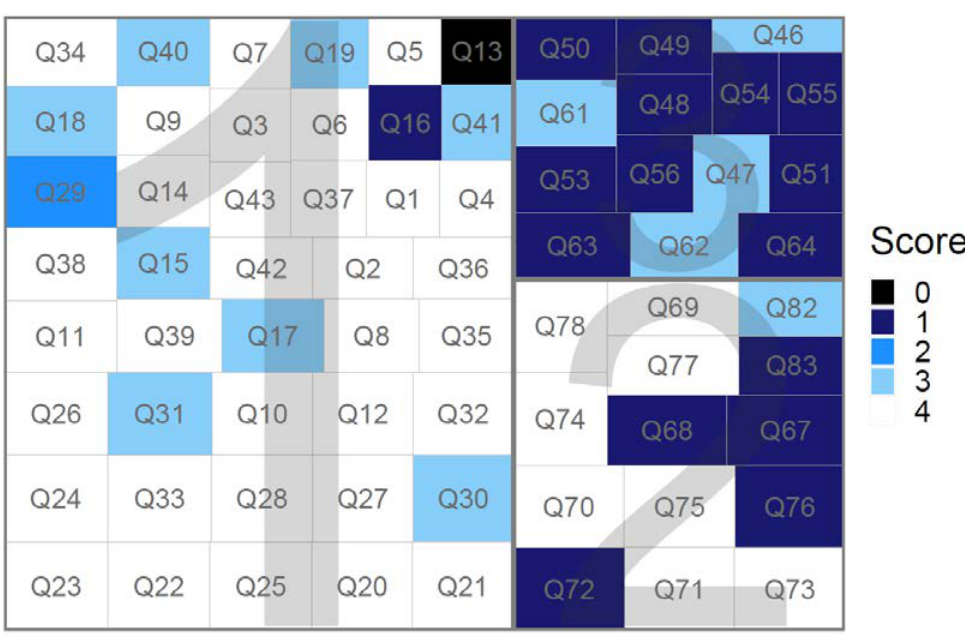
Table 5. Main motor, cognitive, and pain limitations of the groups defined by the diagnosis time of the disease.